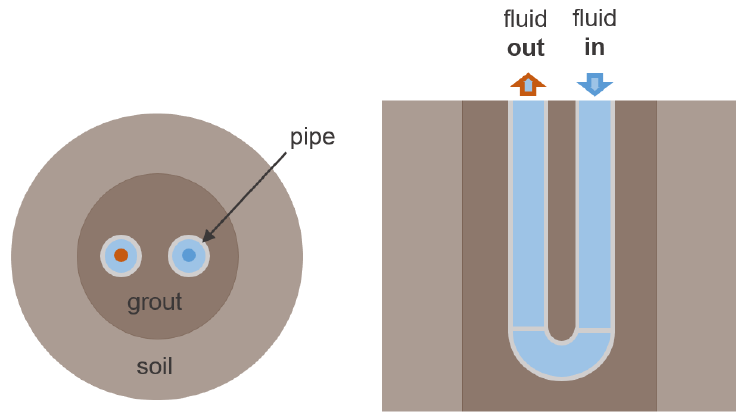
Figure 6. Example of single U-tube borehole heat exchanger.